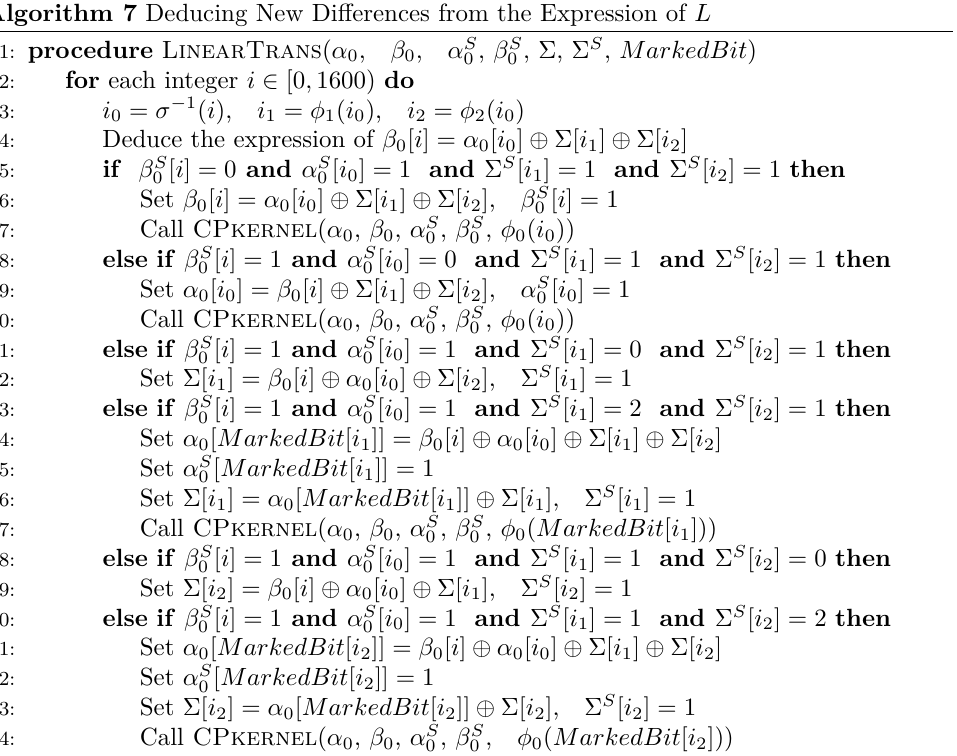
Algorithm 7 Deducing New Differences from the Expression of